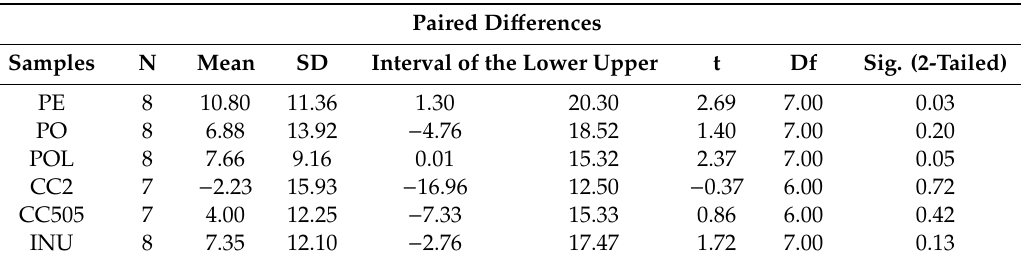
Table 1. Reduction of % DNA in comet tail relative to the control. Paired samples t -test. Paired Di ff erences